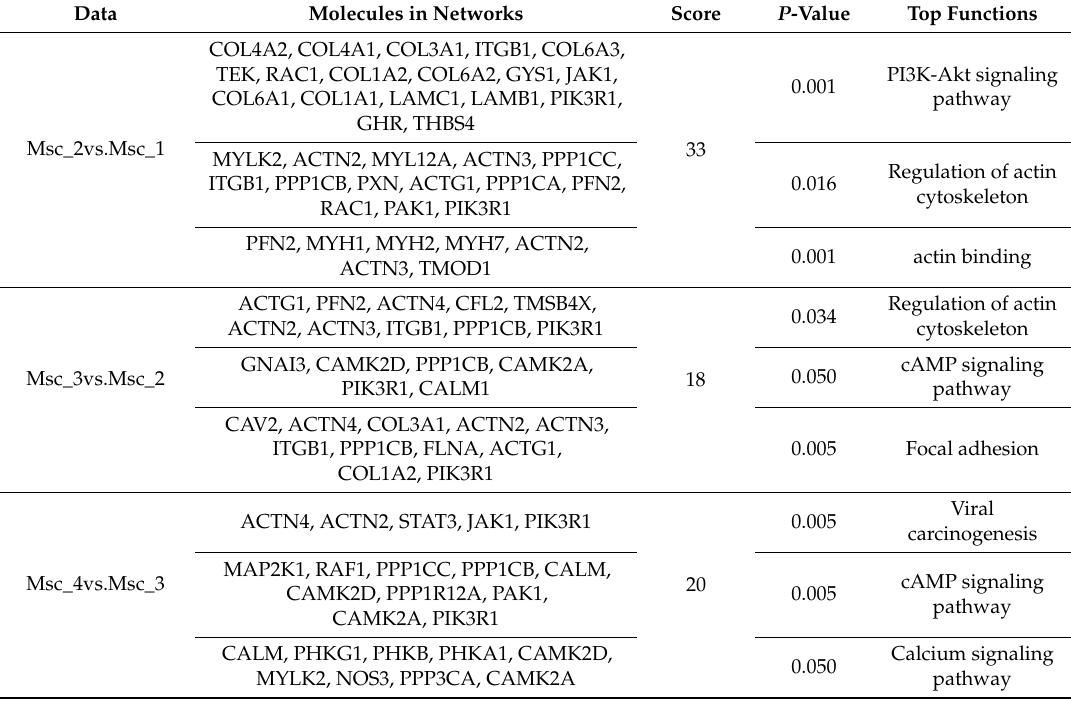
Figure 2. Interaction networks of the top DE unigenes in each comparable group. ( A ) Msc_2 vs. Msc_1. ( B ) Msc_3 vs. Msc_2. (C) Msc_4 vs. Msc_3. The up-regulated unigenes were displayed as red circles, and the down-regulated unigenes were displayed as green circles. Table 1. Summary of the represented networks generated by pathway analysis.